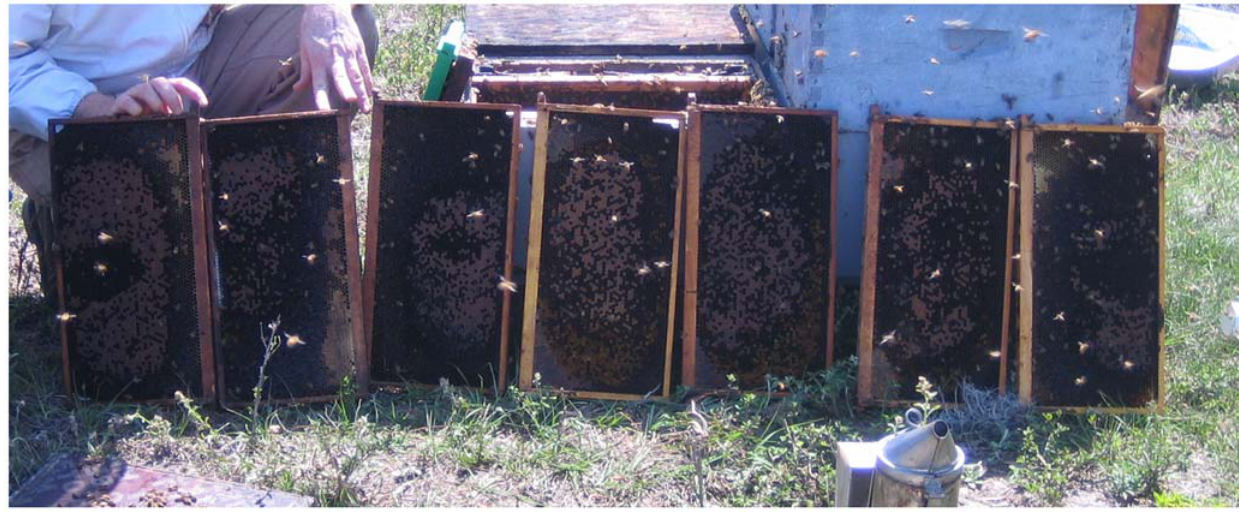
Figure 1. Frames of brood with insufficient bee coverage, indicating the rapid loss of adult bees.